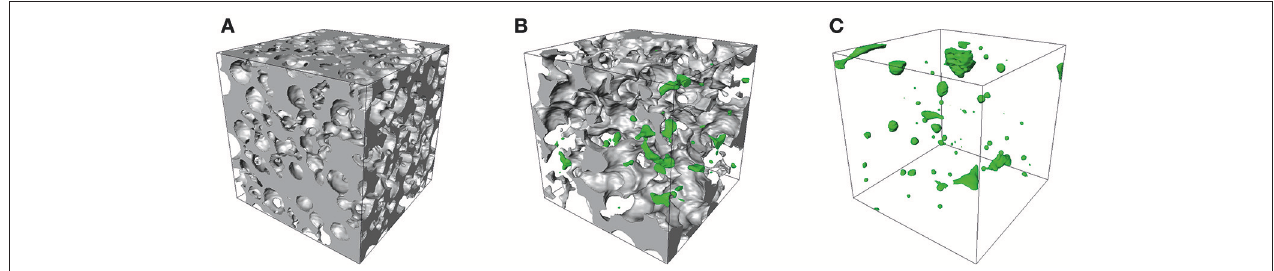
FIGURE 2 | Example textures of variably porous sintered materials for which the pore space is rendered in 3-dimensions and colored gray if it is connected from edge-to-edge in any direction, or green if it is not. The porosities shown are (A) 0.460, (B) 0.290, and (C) 0.014. The box edge length is 0.3mm. The non-pore phase (glass in this case) is made invisible for clarity. These textures are typical of the types of material microstructures that are deformed in the experiments presented herein and are especially relevant to granular or variably welded volcanic deposits. These images were obtained in situ at the Paul-Scherer-Institute (the Swiss Light Source beamline TOMCAT) and are taken with permission from Wadsworth et al. (2017).